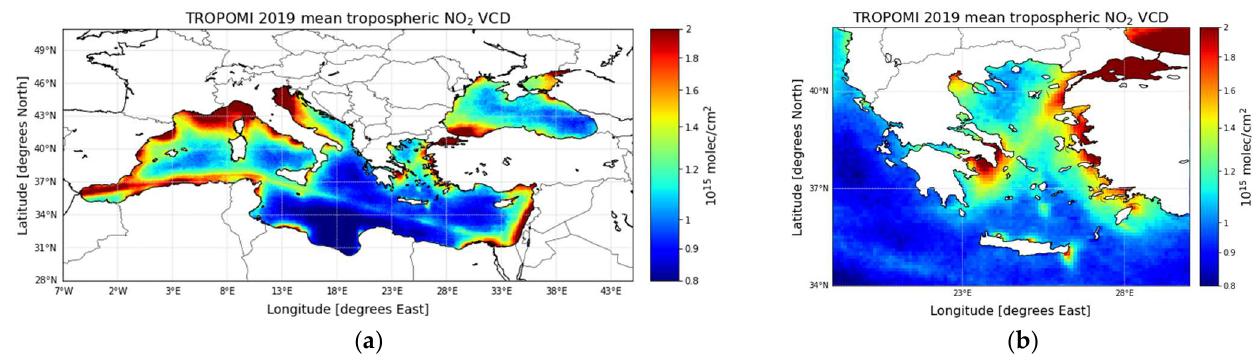
Figure 4. Annual mean TROPOMI tropospheric NO 2 mean vertical column densities (10 15 molecules cm −2 ) for ( a ) the Mediterranean and the Black Sea regions; ( b ) the Greek domain.